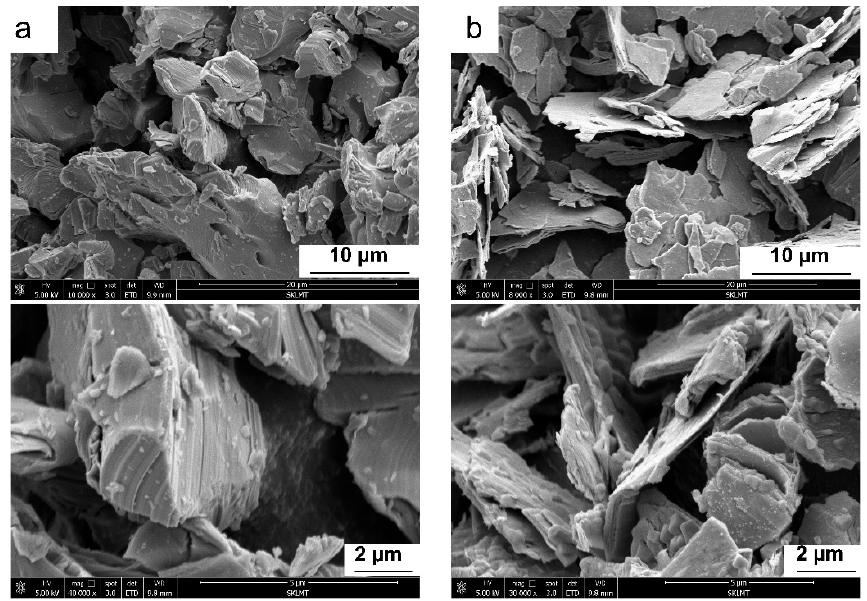
Figure 2. SEM images of Ti 3 AlC 2 before ( a ) and after ( b ) HF etching for 72